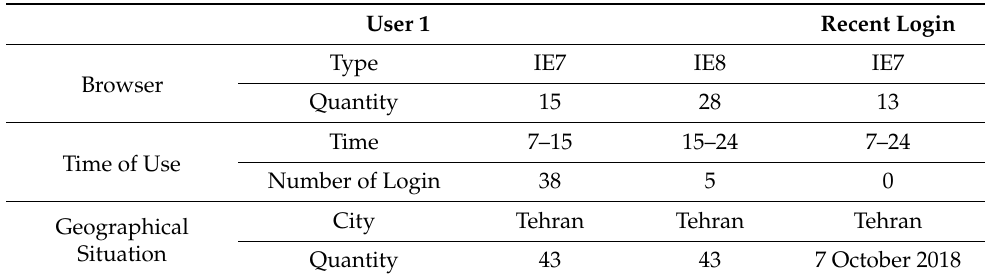
Table 9. Profile of user 1 (source: research analysis).